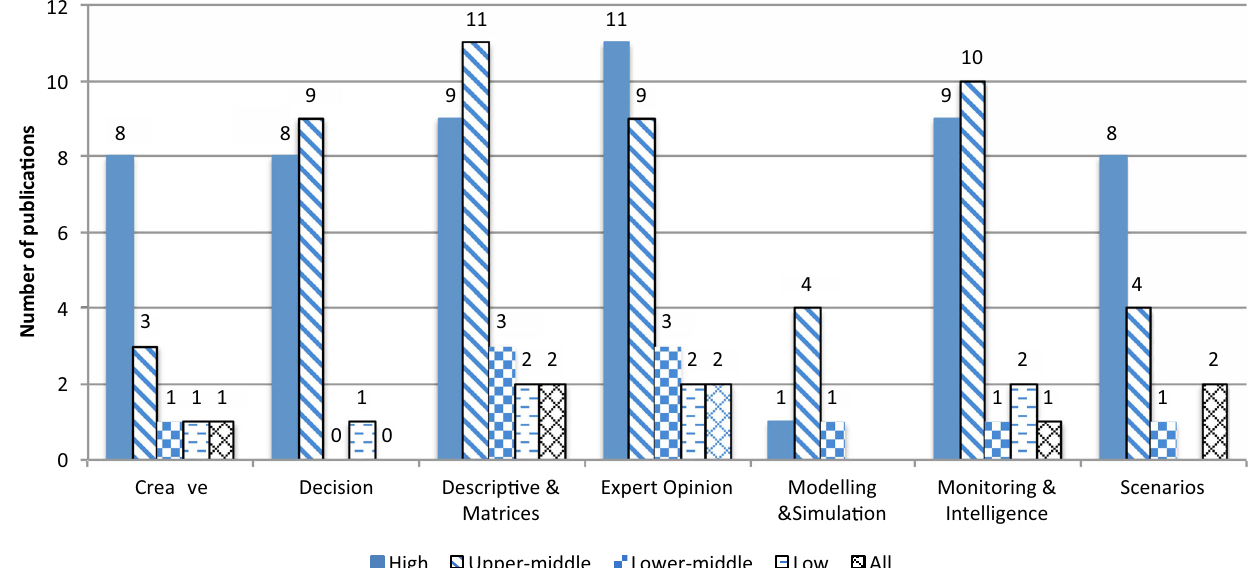
Fig. 2 Publications per family of methods of FTA per country income